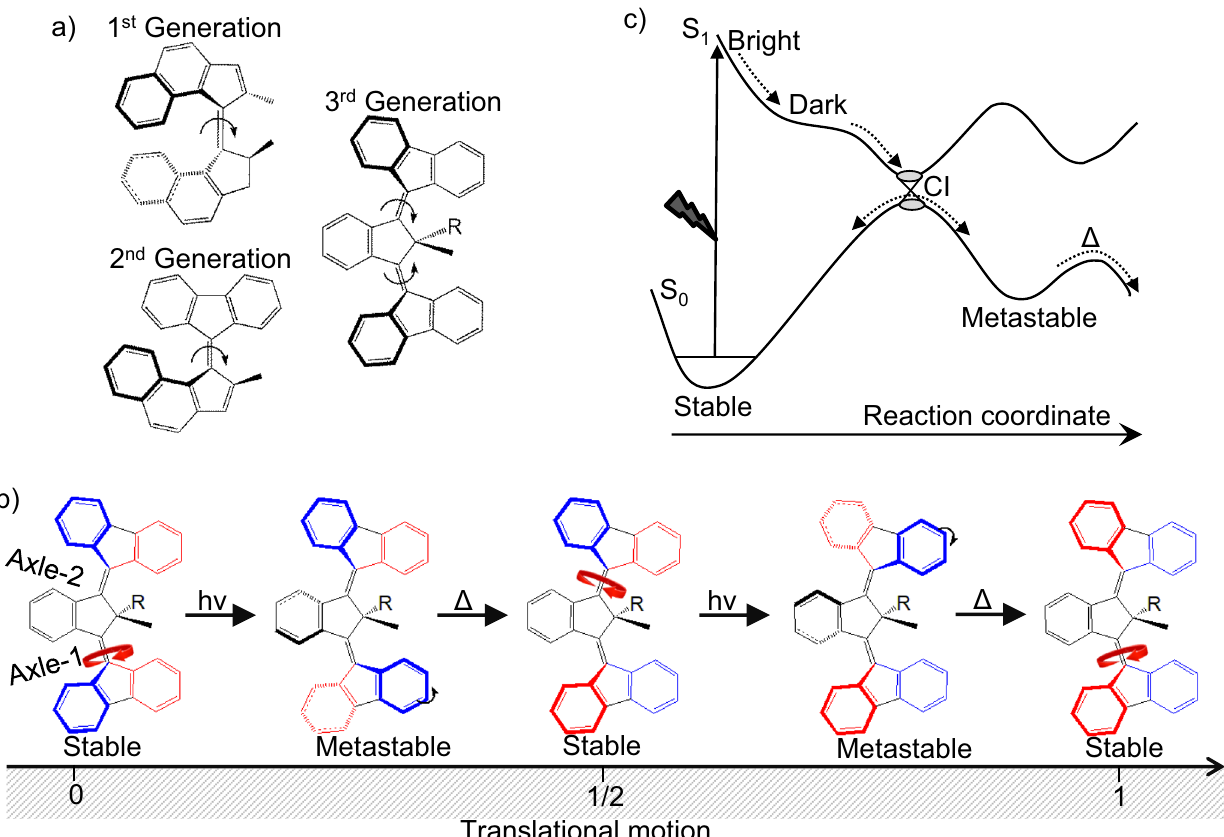
Fig. 1 | Structures of successive generations of unidirectional motors and the uniquefunctionof3GMs.a Structuresofthreegenerationsofunidirectionallight- driven rotational motors; thicker lines indicate atoms above the plane of the page, light lines below. b Illustration of the potential of cooperative rotation in 3GMs to